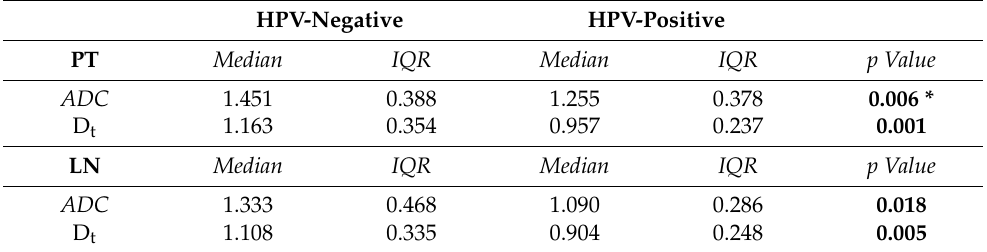
Table 3. ADC and D t coefficients in primary tumors (PTs) and metastatic lymph nodes (LNs).